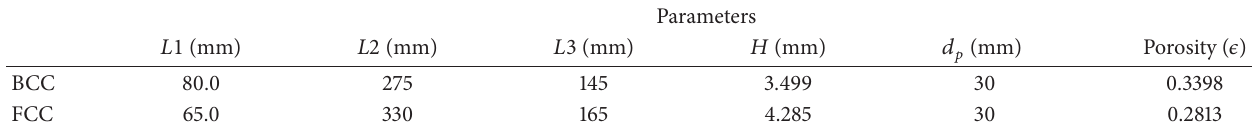
Table 1: Geometry parameters of BCC and FCC model.